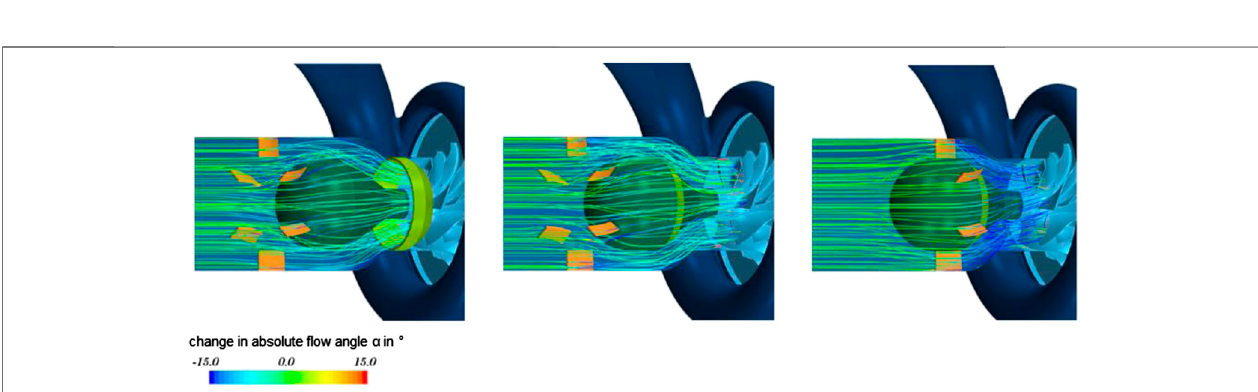
FIGURE 8 | Comparison of the axial velocity distribution for a cone and two ori fi ce variants at low mass fl ow.